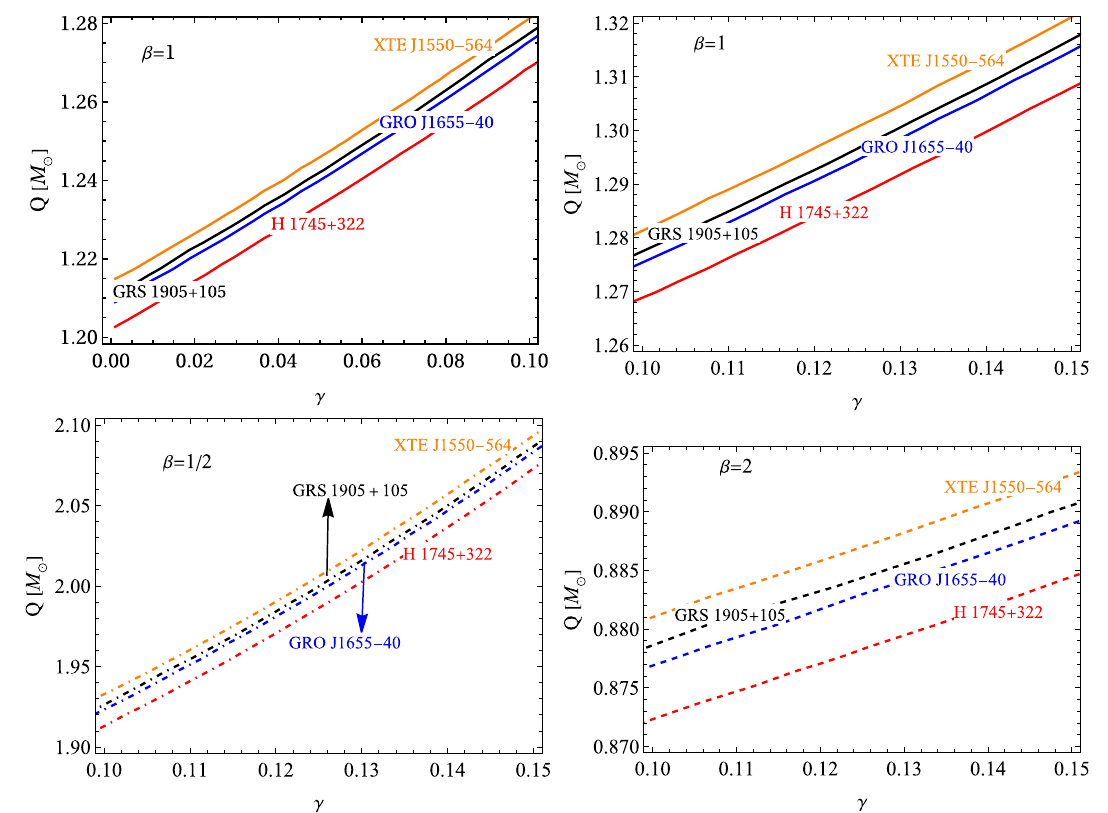
Fig. 16 The same figure with Fig. 15 but for the different range of γ , the figure from the top left corner accounts for from 0 to 0.1, while the others from 0.1 to